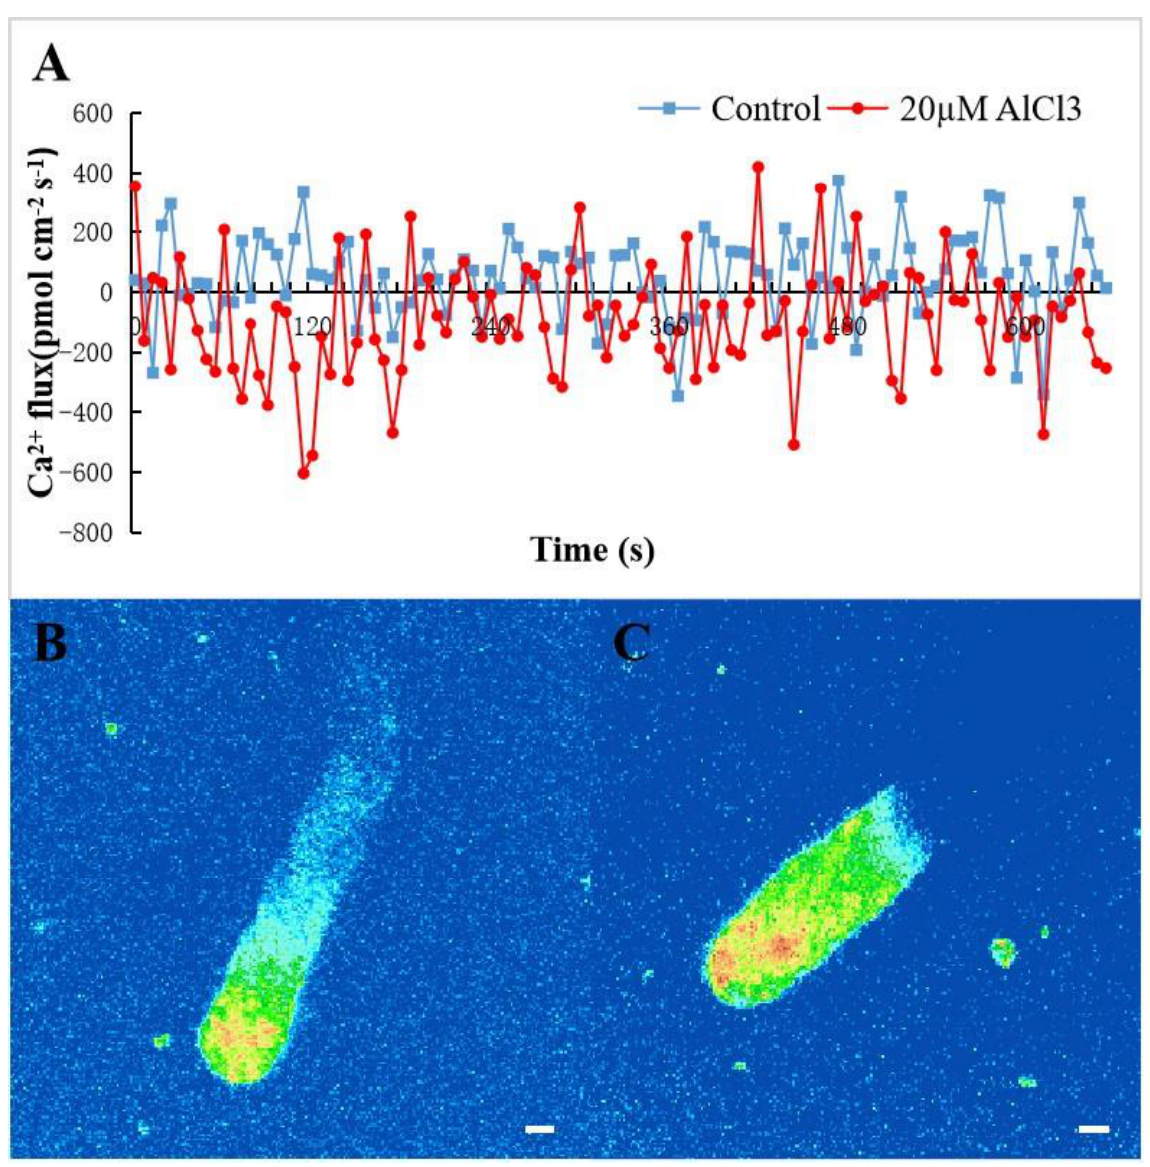
Figure 2. Effects of 20 µM AlCl 3 on Ca 2+ flux and [Ca 2+ ]c in pollen tubes of M. domestica. ( A ) Ca 2+ flux of M. domestica pollen tube apex under different condition. The blue line stands for Ca 2+ flux of control pollen tube, while red line represents Ca 2+ flux of pollen tubes treated with 20 μM. ( B ) The [Ca 2+ ]c at the tip of the control pollen tube labeled with Fluo-3/AM ester under CLSM. ( C ) The [Ca 2+ ]c at the tip of the pollen tube treated with 20 μM AlCl 3 . Bar = 10 µm. Note: The negative value of Ca 2+ flux represents absorption (influx), and the positive value represents efflux.